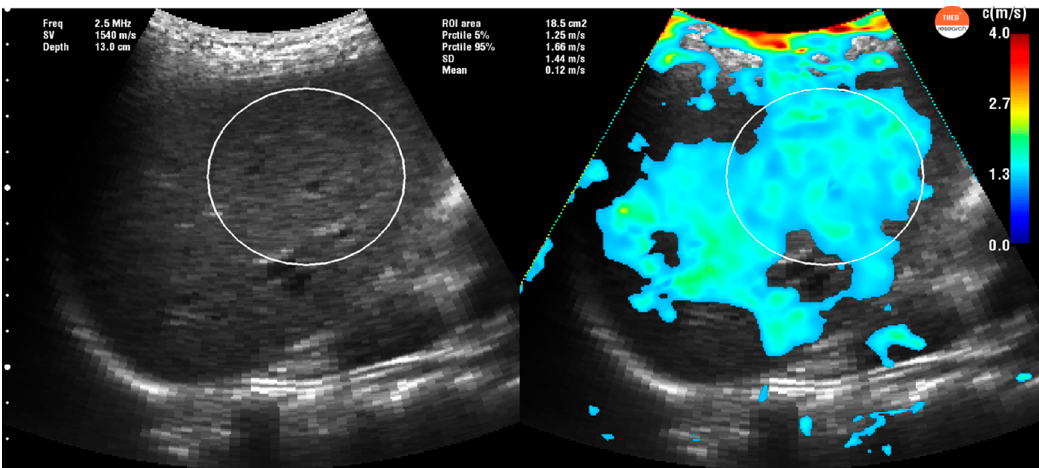
Figure 1. Liver sti ff ness measurement obtained with THE-Time Harmonic Elastography in a normal patient. In this picture, we can see the wide liver approach thru the intercostal section and the acquisition of the liver sti ff ness measurement (in the right side of the figure) reflecting healthy liver in cyan-green. Region of interest (ROI) is selected in the most homogeneous area. The current ROI has an area of 18.5 cm 2 with a corresponding liver sti ff ness (mean ± SD, (5% percentile, 95% percentile)) of shear wave speed = 1.44 m / s ± 0.22 m / s (1.25 m / s, 1.66 m / s) and Young’s modulus = 6.22 kPa ± 1.90 kPa (4.69 kPa, 8.27 kPa), respectively.